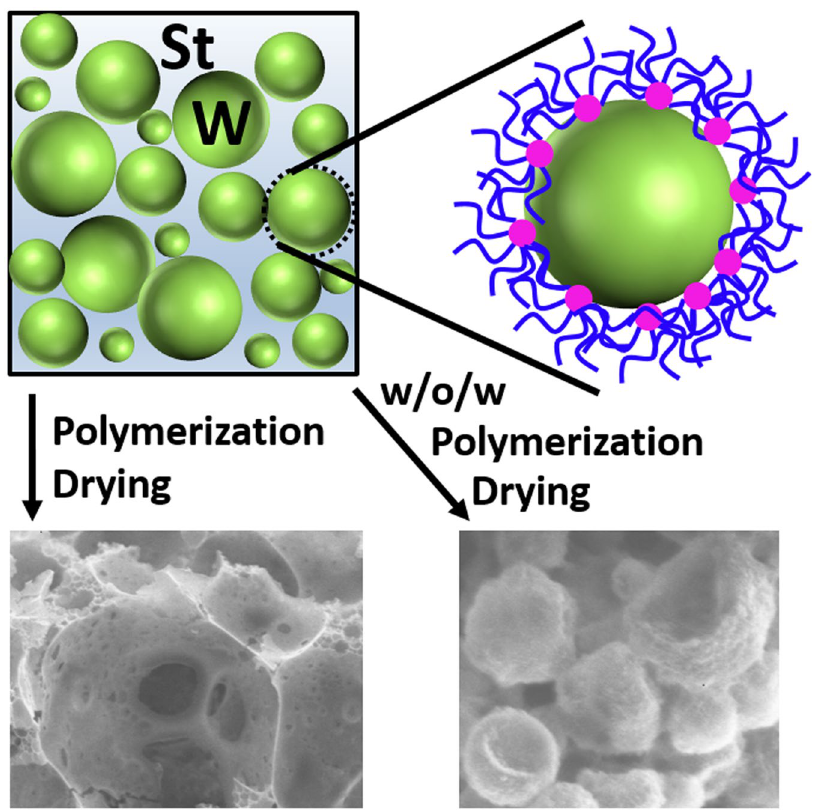
Figure 6. Schematic representation of styrene porous materials prepared from PBzMA CCS polymer-stabilized